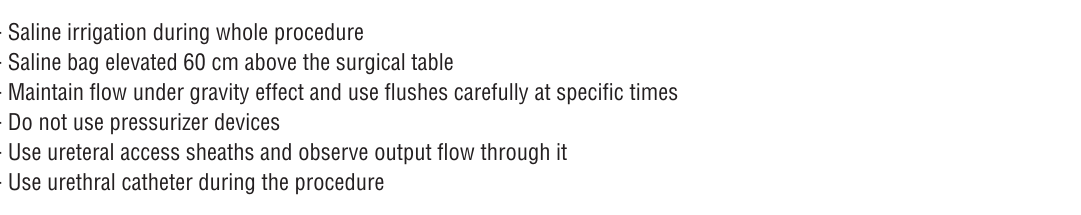
Table 1 - Take Home messages about intra-renal pressure and temperature for a safety ureterolithotripsy To keep intra-renal pressure in a safe